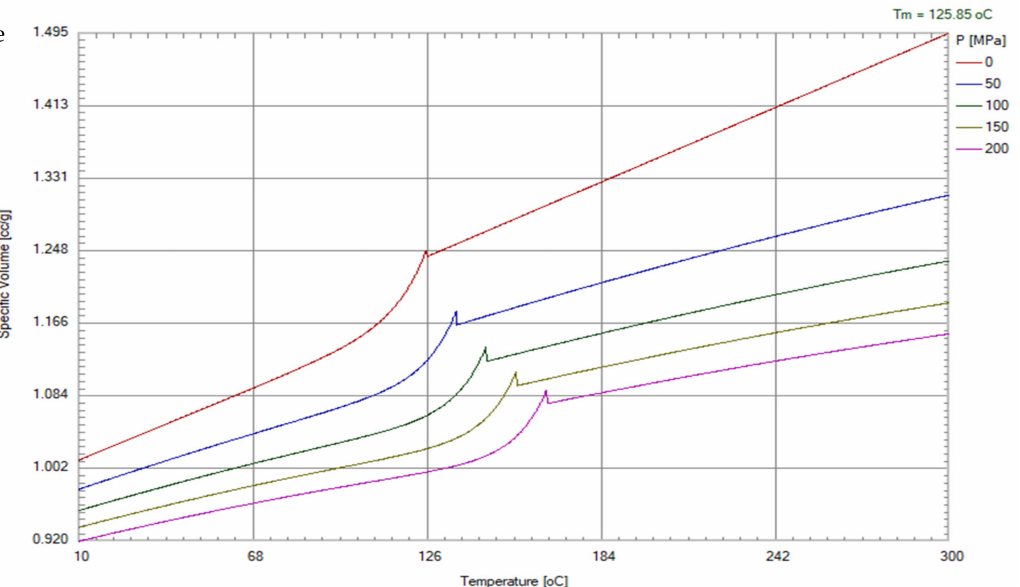
Figure 2. Properties of recycled PP: ( a ) relative crystallinity with respect to shear rate and cooling rate; ( b ) constant pressure heat capacity with respect to temperature; ( c ) thermal conductivity with respect to temperature; ( d ) viscosity with respect to temperature; ( e ) pressure–volume–temperature